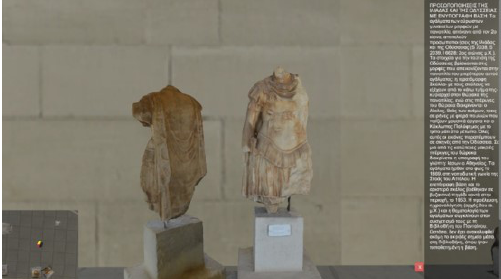
Figure 7: The virtual museum with all included